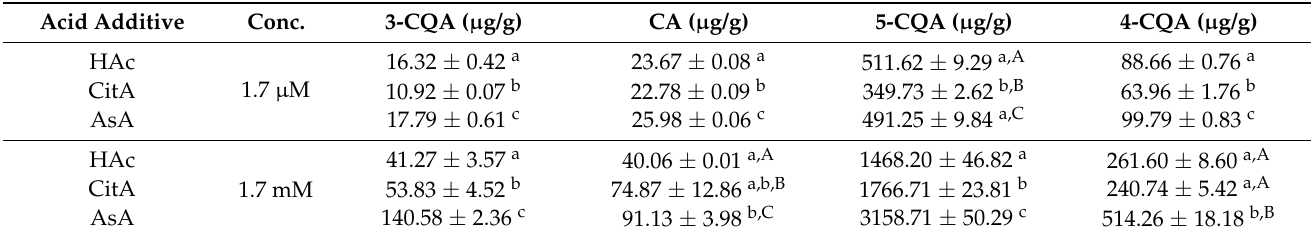
Table 5. Phenolic acid content ( µ g/g) in a fresh sprout sample extracted with different acid additives (HAc, CitA and AsA) at two different concentrations (1.7 µ M and 1.7 mM). Results are expressed as mean value ± standard deviation ( n =